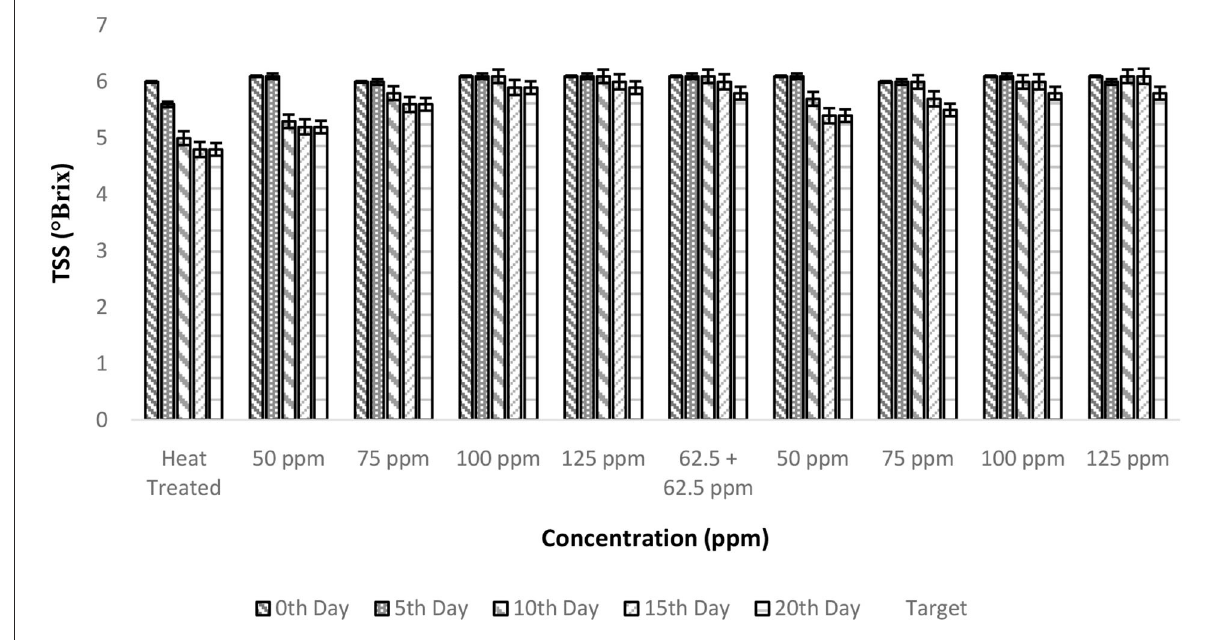
FIGURE2 Total soluble solids (TSS) vs. concentration plot of bio-preservatives during the storage period.